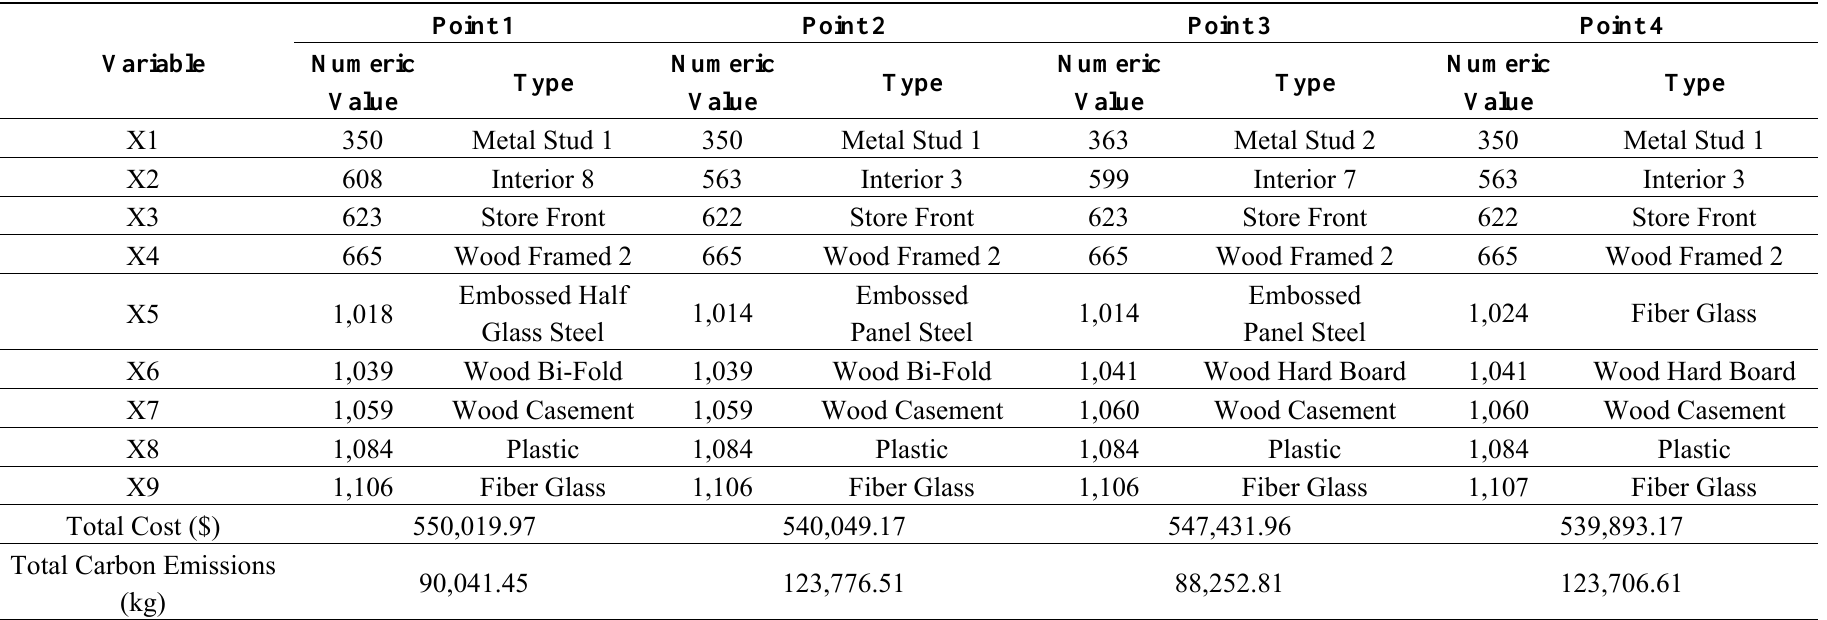
Table 7. Optimal Solutions based on Scenario